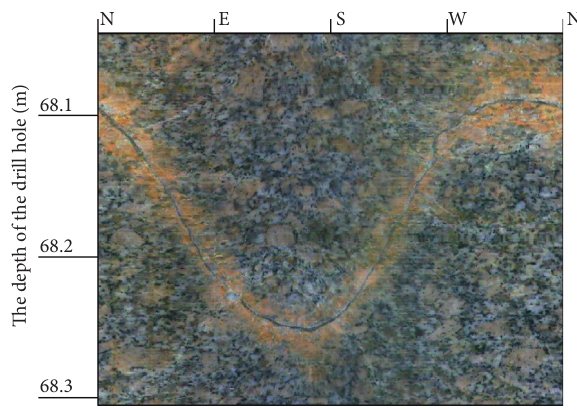
Figure 3: Picture of the borehole televiewer.